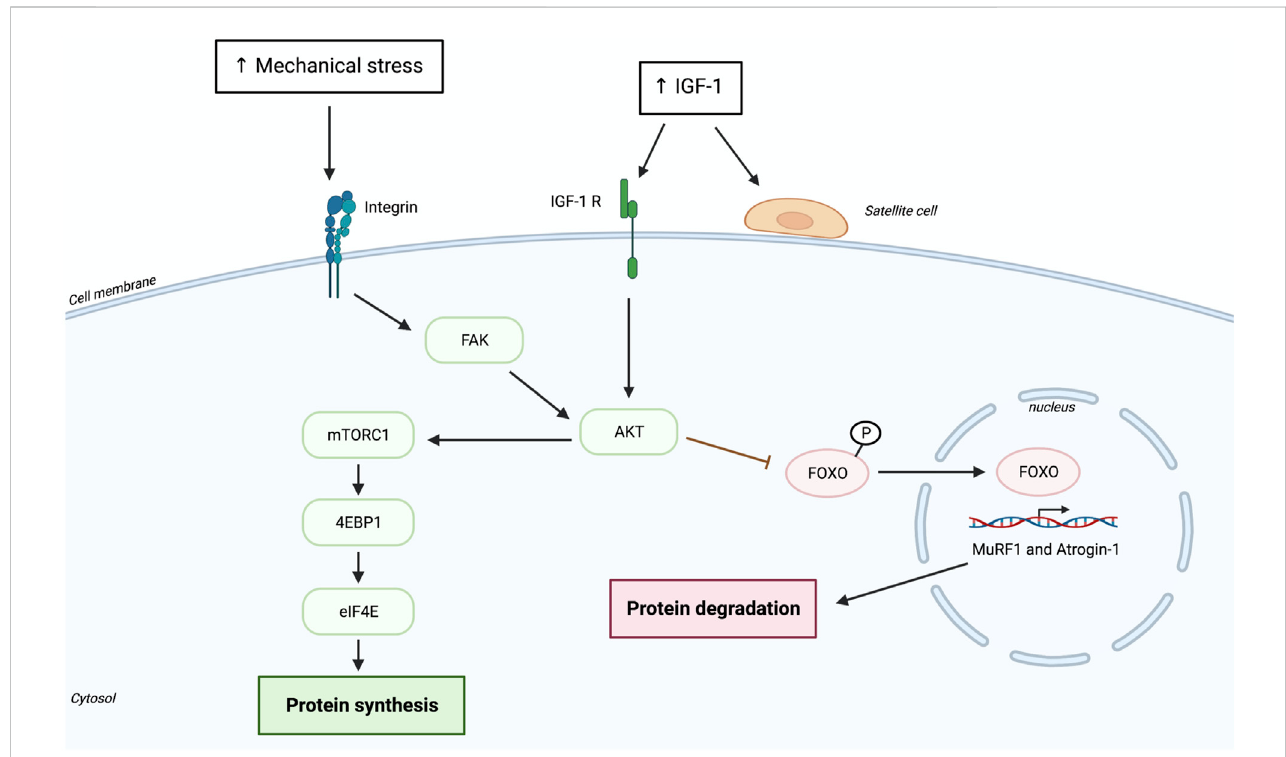
FIGURE 1 Pathways leading to the activation of AKT/mTOR signals after resistance